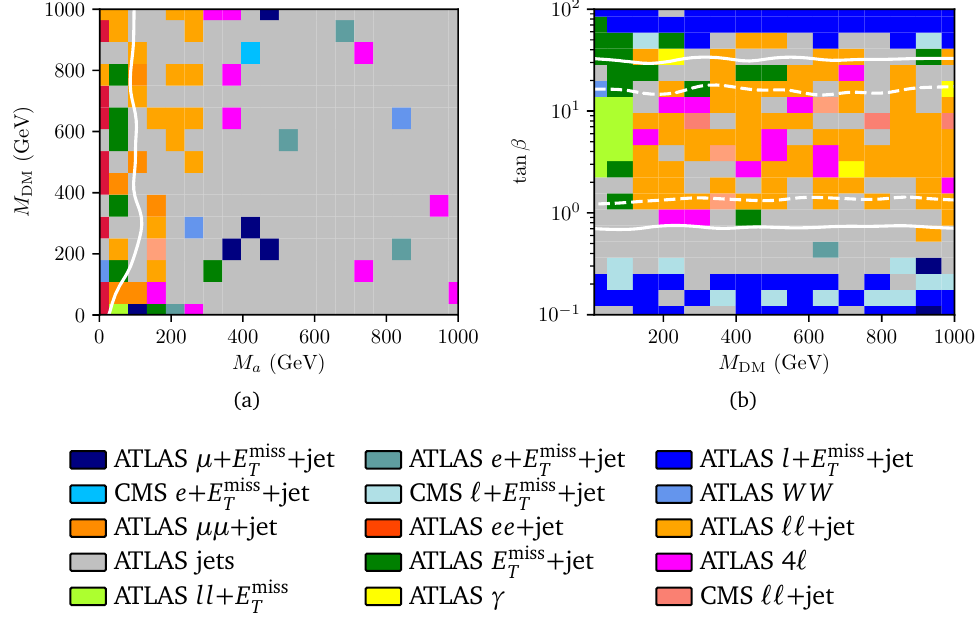
Figure 5: Sensitivity scans in (a) M indicate the most sensitive set of measurements. The 95% (68%) excluded contours are indicated by solid (dashed) white lines; note that the whole plane in M is excluded at 68% confidence level. All other parameters are as given in Table